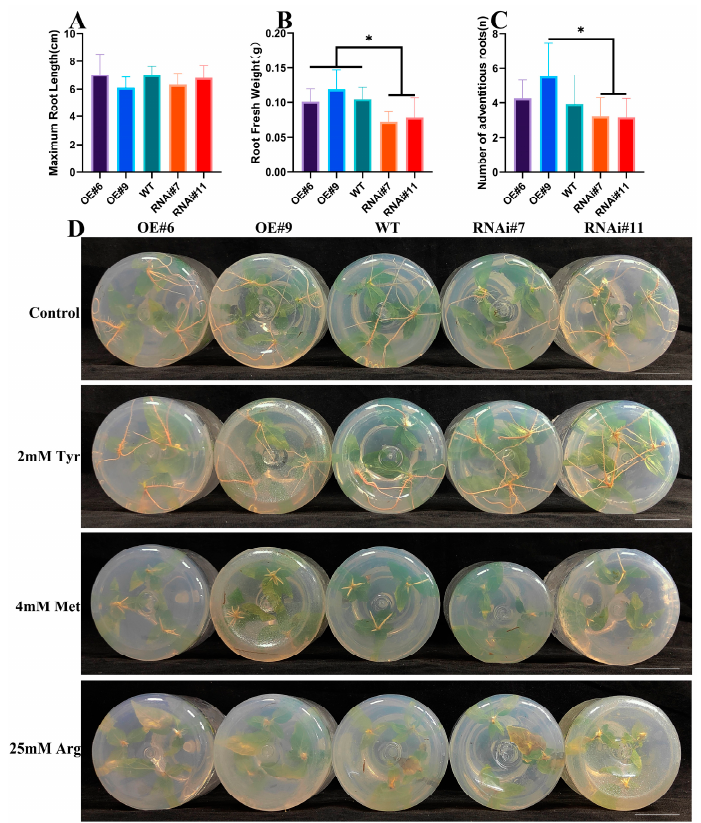
Figure 6. Phenotype determination. Phenotypic determination of maximum root length ( A ), root fresh weight ( B ), and the number of adventitious roots ( C ) for tissue cultured seedlings. Analysis based on ANOVA * p < 0.05. ( D ) The phenotype of transgenic lines treated with amino acids, scale = 3 cm.